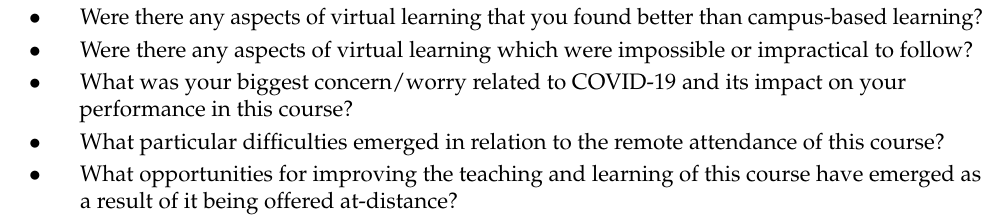
Table 1. Open-ended questions of the survey delivered to our